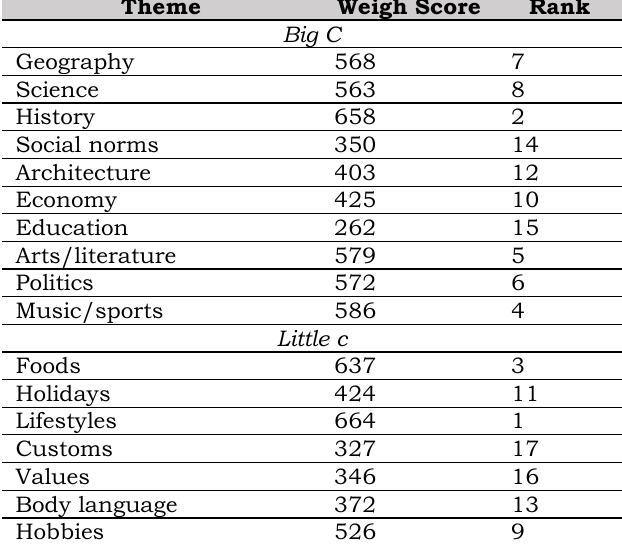
Table 4. Students’ preference for cultural